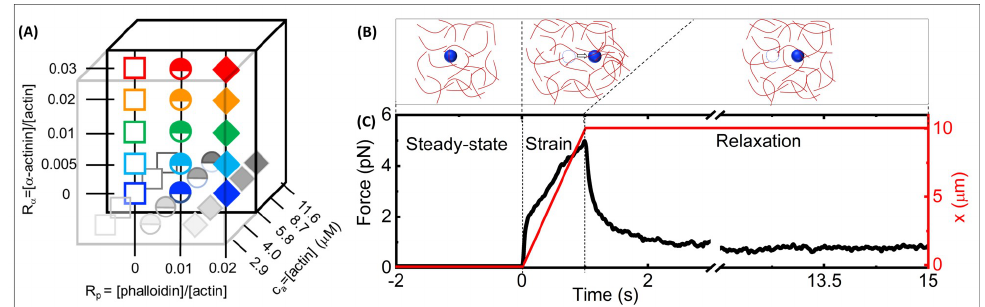
Figure 1. Optical tweezers microrheology characterizes the nonlinear force response of actin net- works with varying molar concentrations of actin monomers, α -actinin and phalloidin : ( A ) Car- toon of experimental parameter space of filamentous actin networks with varying: α -actinin:actin molar ratios, R α = 0–0.03 ( y -axis), phalloidin:actin molar ratios R p = 0–0.02 ( x -axis), and molar actin monomer concentrations, c a = 2.9–11.6 µ m ( z -axis). ( B ) Optical tweezers microrheology (OTM) measurement protocol: an optically trapped 4.2- µ m diameter microsphere probe (blue) embedded in an actin network (red) is: held fixed for 15 s to allow the network and probe to reach steady-state and establish a baseline (left, steady-state), displaced x = 10 µ m at a constant speed v = 10 µ m/s by moving the piezoelectric stage relative to the trap (middle, strain), and held fixed while the network relaxes to a new steady-state (right, relaxation). The dashed circles represent the initial probe position, and the arrow indicates the trap motion during strain. ( C ) A sample OTM measurement showing the measured force exerted on the trapped probe (black) and the stage position versus acquisition time. The dashed vertical lines divide the data into the three phases depicted in ( B